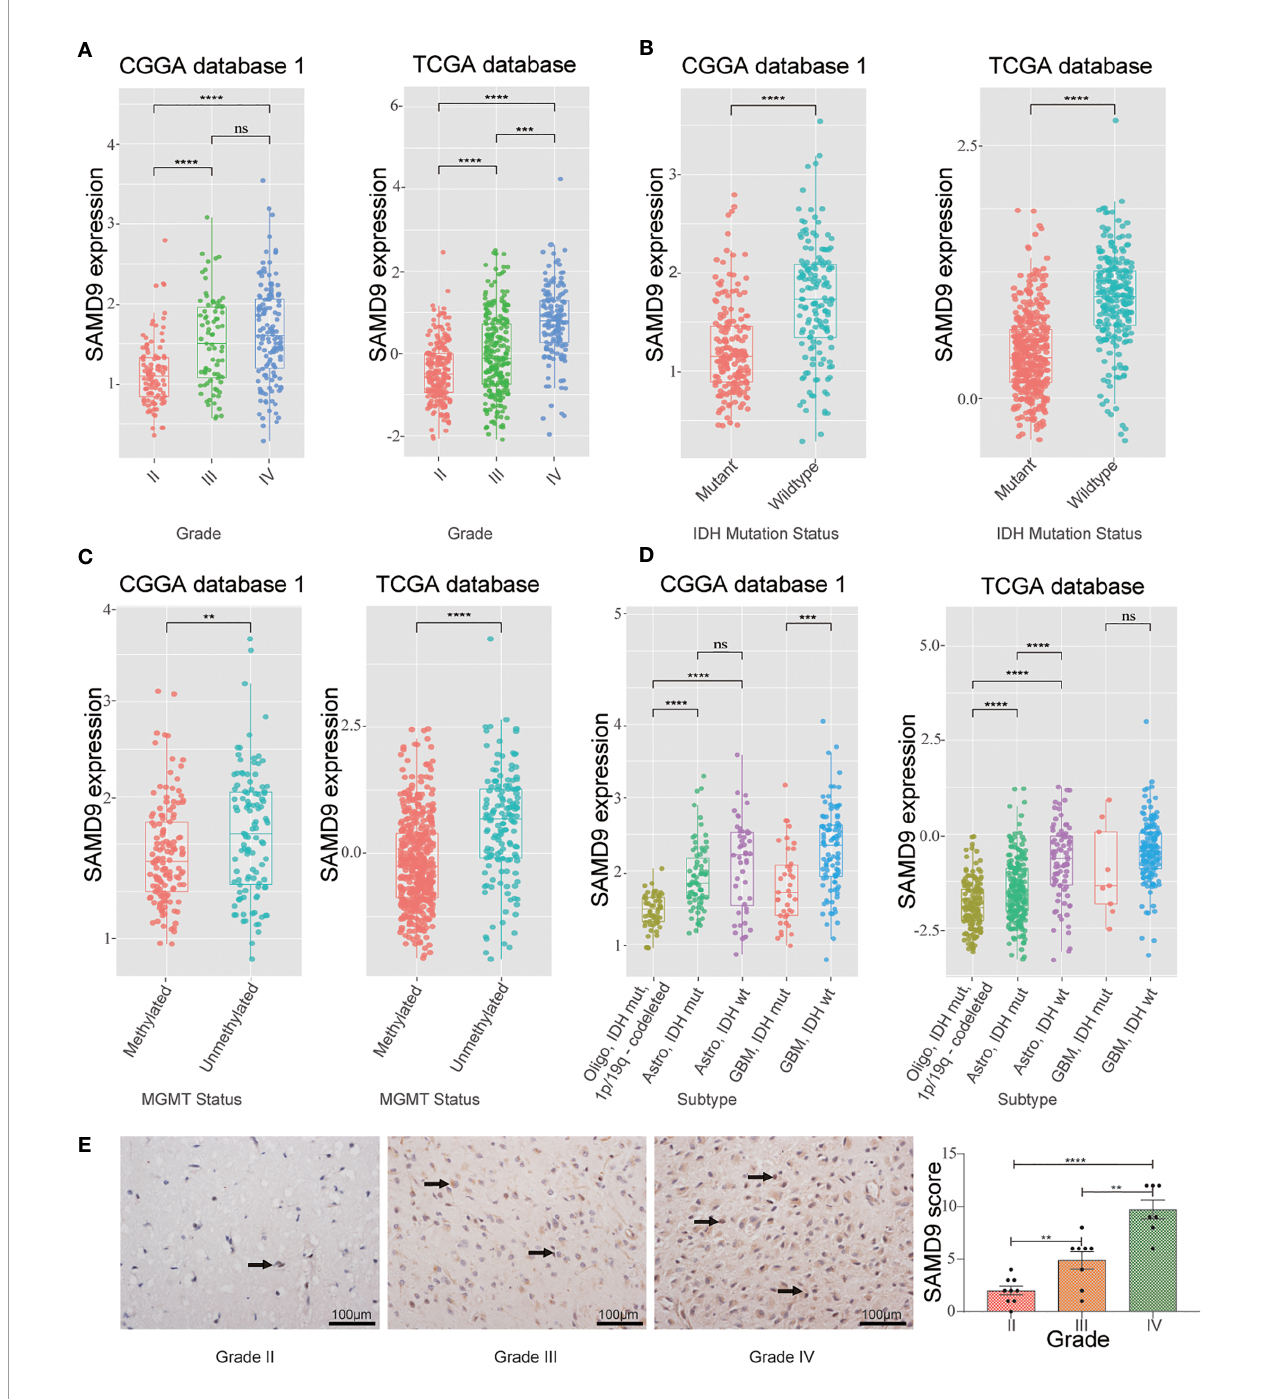
FIGURE 1 | WHO grade, IDH1 status, MGMT promoter methylation status and transcriptional characteristic subtype relative to SAMD9 expression. (A) The correlation of SAMD9 expression level with WHO grade. SAMD9 expression levels in glioma of WHO grade II-IV in CGGA database 1 and TCGA database, the difference between III & IV in TCGA database. (B) The relationship between SAMD9 transcription level and IDH1 mutation in CGGA and TCGA databases. (C) The correlation of SAMD9 expression level and MGMT promoter methylation status, the difference in CGGA database 1 and in TCGA database. (D) The relationship between SAMD9 transcription level and IDH1 mutation in each transcriptional characteristic subtype in CGGA and TCGA databases. (E) SAMD9 expression in different grades of gliomas (Grade II, n=7; Grade III, n=8; Grade IV, n=9) detected by IHC analysis. Scale bar = 100 mm. **, ***, **** and ns indicate p < 0.01, p < 0.001, p < 0.0001 and no signi fi cance,